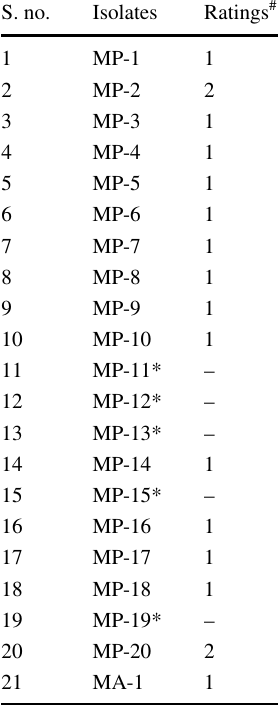
Table 1 Cellulose degradation capability of bacteria isolated from microbial consortium (Madhyam)